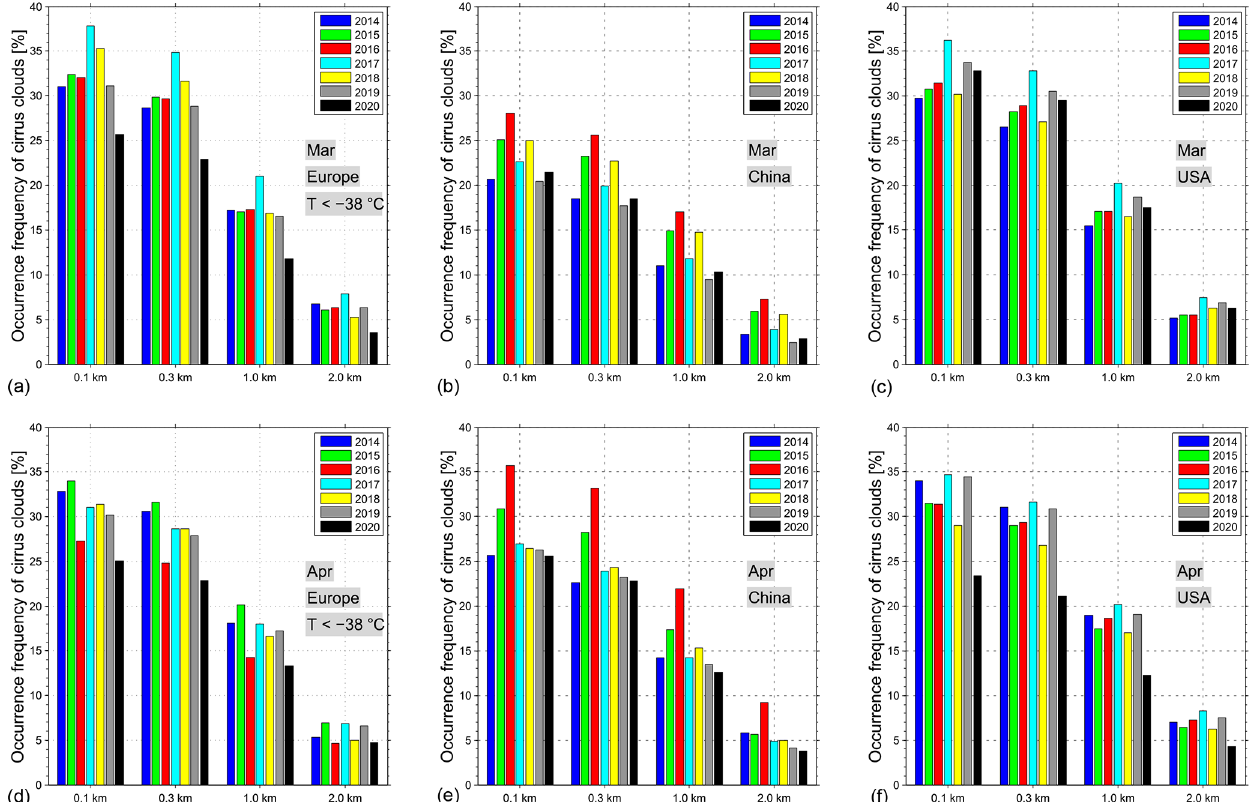
Figure 10. Histograms of the cirrus occurrence rates in the years from 2014 to 2020 over Europe (a, d) , the USA (b, e) , and China (c, f) , with the definitions based on different cloud thicknesses larger than 0.1, 0.2, 1.0, and 2.0km, respectively. Panels (a) – (c) are for the observations in March; panels (d) – (f) are for